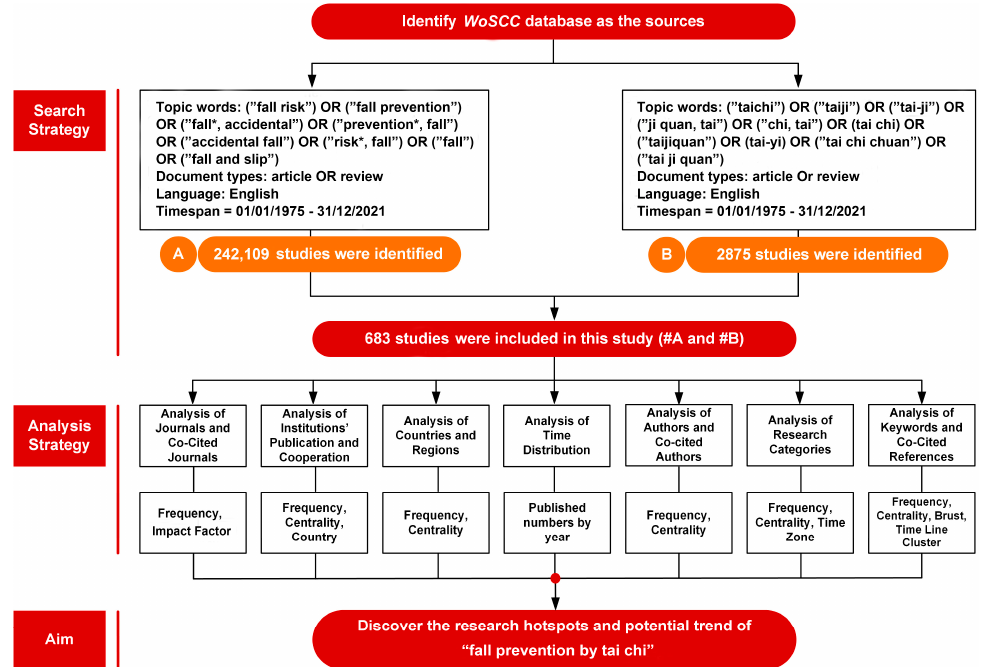
Figure 1. The flowchart of the research